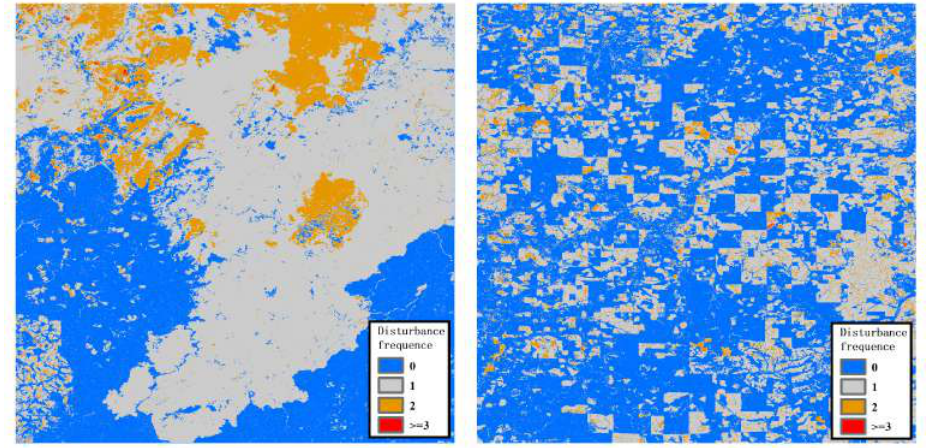
Figure 11. Mapping results of forest disturbance frequencies. Left area B is dominated by 1 or 2 times disturbances while right area A dominated with more than 3 times number of forest disturbances within 35 years.